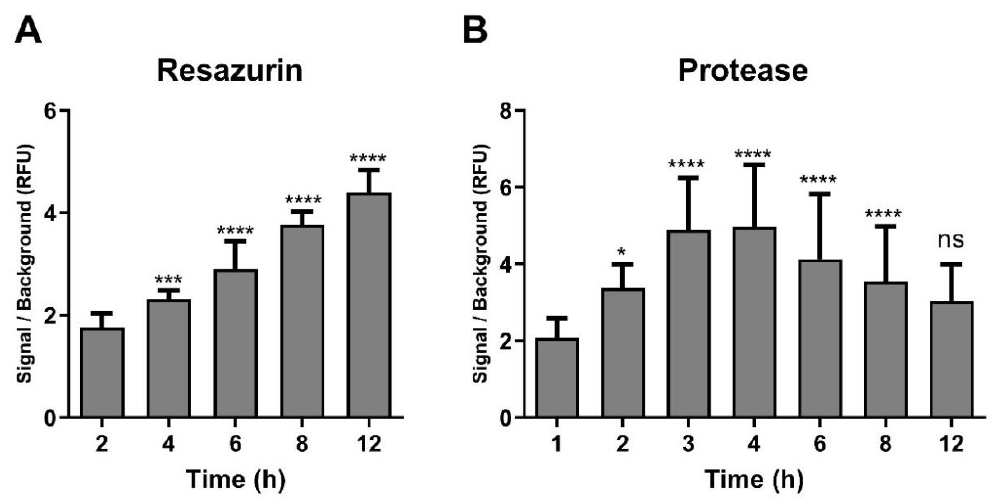
Figure 2. Optimisation of exposure times for the resazurin and GF-AFC substrates. Plates were incubated with ( A ) resazurin, or ( B ) GF-AFC substrates and analysed at different time points. Data are expressed as mean ± standard deviation from three independent assays with four replicates each. ns = not significant ( p > 0.05), * p < 0.05, *** p < 0.001, **** p < 0.0001 (one-way ANOVA with Dunnett multiple comparisons test compared with the first timepoint group).